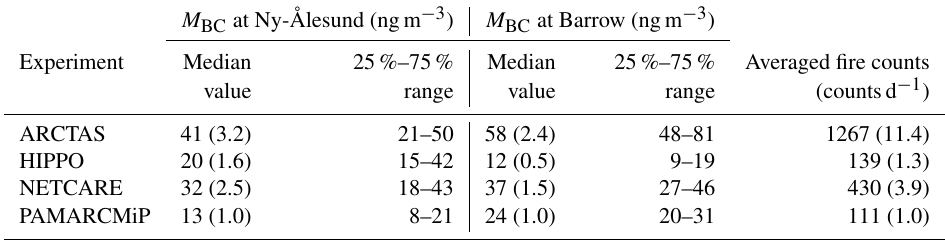
Table 6. BC mass concentrations observed at the ground